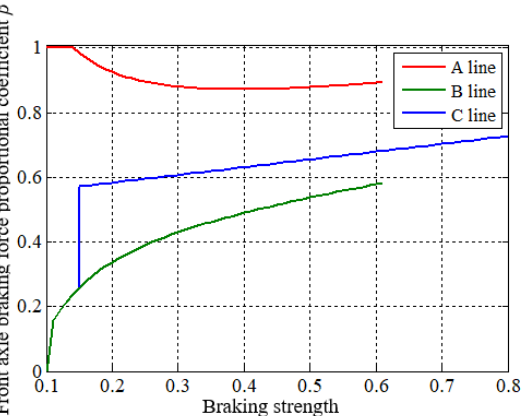
Figure 6. Relationship curve between braking force distribution coefficient and braking strength.